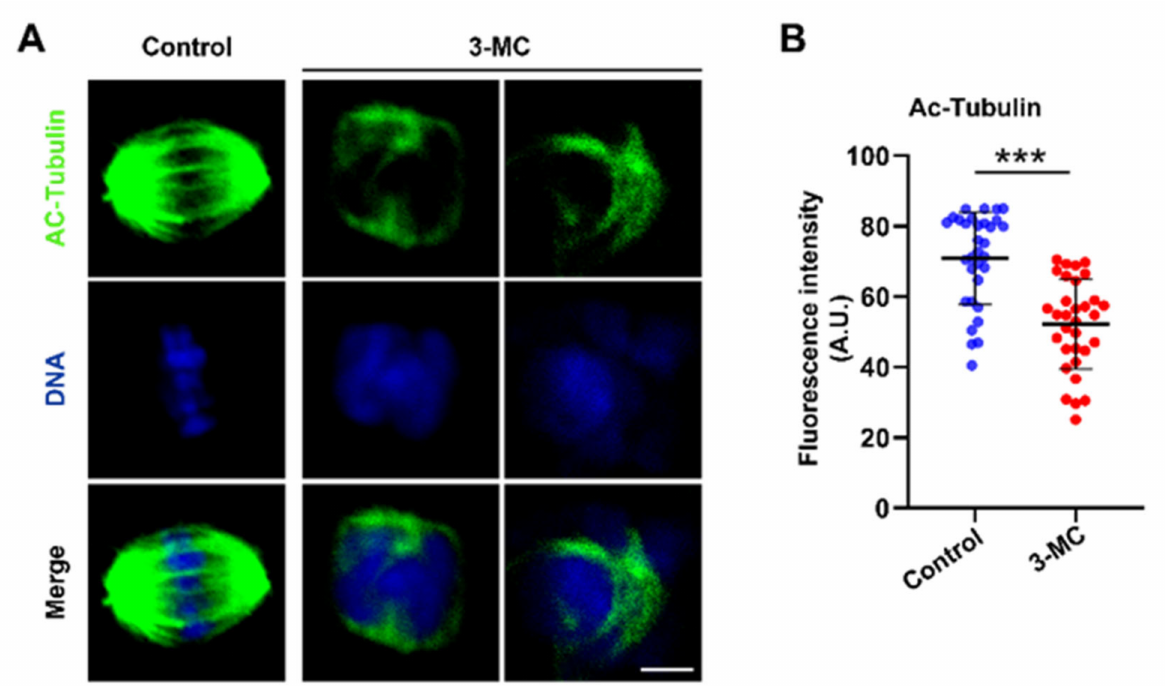
Figure 3. Effects of 3-MC exposure on the acetylation level of α -tubulin in porcine oocytes. ( A ) Rep- resentative images of acetylated α -tubulin in the control and 100 µ M 3-MC exposure groups, scale bar 3.5 µ M; ( B ) the fluorescence intensity of acetylated α -tubulin was quantitatively analyzed in each group. Data were presented as mean ± S.E.M of at least three independent experiments. *** p <